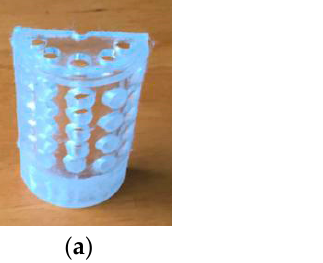
Figure 6. Wellhead model during the recharge test. ( a ) Round IAF wellhead; ( b ) square IAF wellhead; and ( c ) recharge pool.